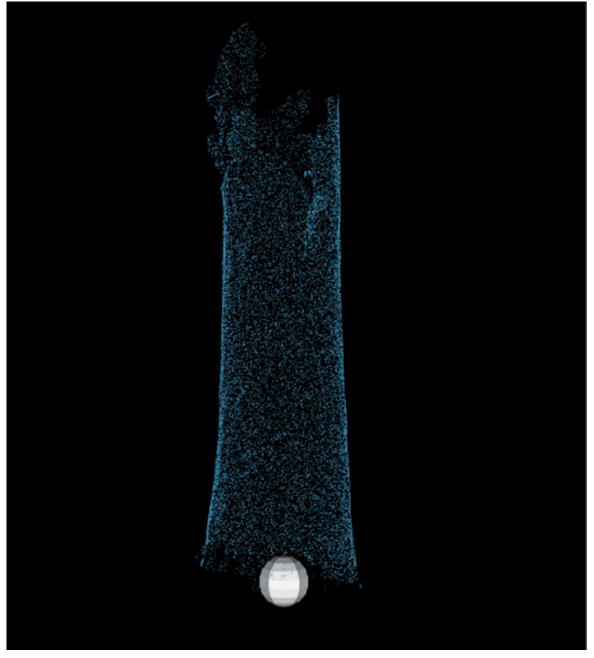
Figure 14. Identifying the tree base using the position lowest point function in the 3D Forest soft- ware.